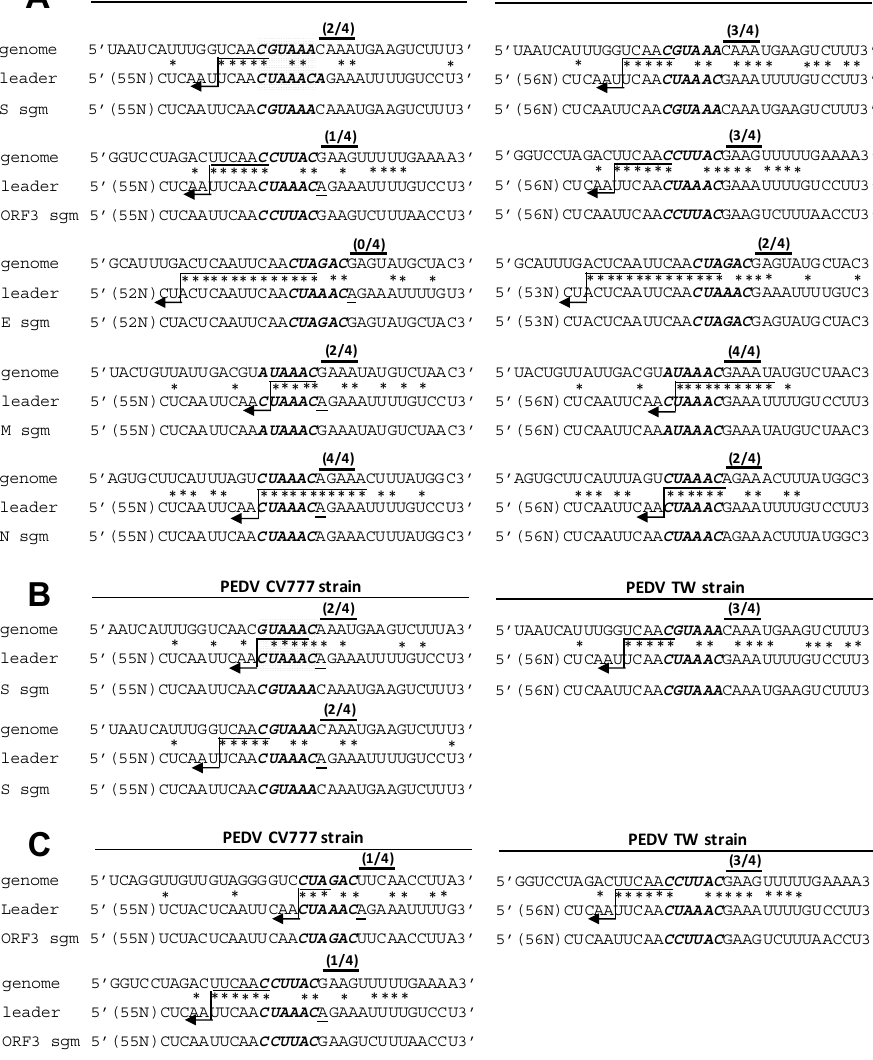
Figure 5. Alignment of identified fusion sites in the genome with the 5 ′ end of the CV777 strain (left panel) or TW strain (right panel). CS-B and CS-L are identified by shading. The identity of clustered base similarities within the 14-nt region (including the 4-nt 5 ′ -TRS, 6-nt CS-B, and 4-nt 3 ′ -TRS) immediately surrounding the CS-B is also shown. Nucleotide identity between sequences is indicated using an asterisk. The number of nt identity among the 4-nt 3 ′ -TRS is indicated above the 3 ′ -TRS. Postulated polymerase strand-switching during minus-strand synthesis is indicated by an arrow. Because the CS-B for the S and ORF3 genes for CV777 are unknown, the currently assumed CS-B for the two genes is shown in the left panel of ( A ). The previously (upper left panel) and currently (lower left panel) assumed CS-B for the S gene and ORF3 genes for CV777 is also used for the alignment, as shown in the left panel of ( B ) and ( C ), respectively.